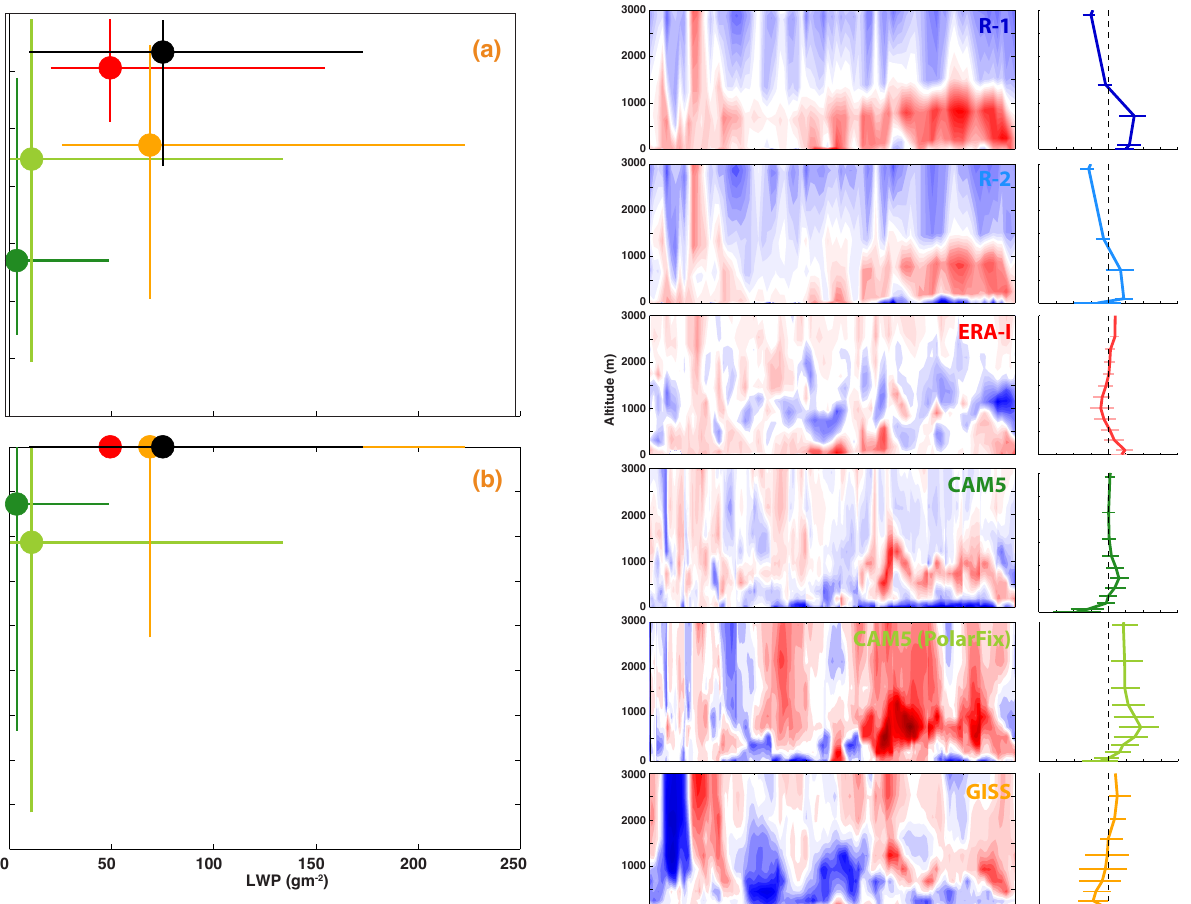
Fig. 8. Figures demonstrating the range of values of liquid water path for observations and models that provide it, as well as its re- lationship to surface net longwave radiation (a) , and cloud fraction (b) . The circles represent the mean value over the ASCOS observa- tional period, and the whiskers demonstrate the extent of the 10th and 90th percentiles of the data sets.